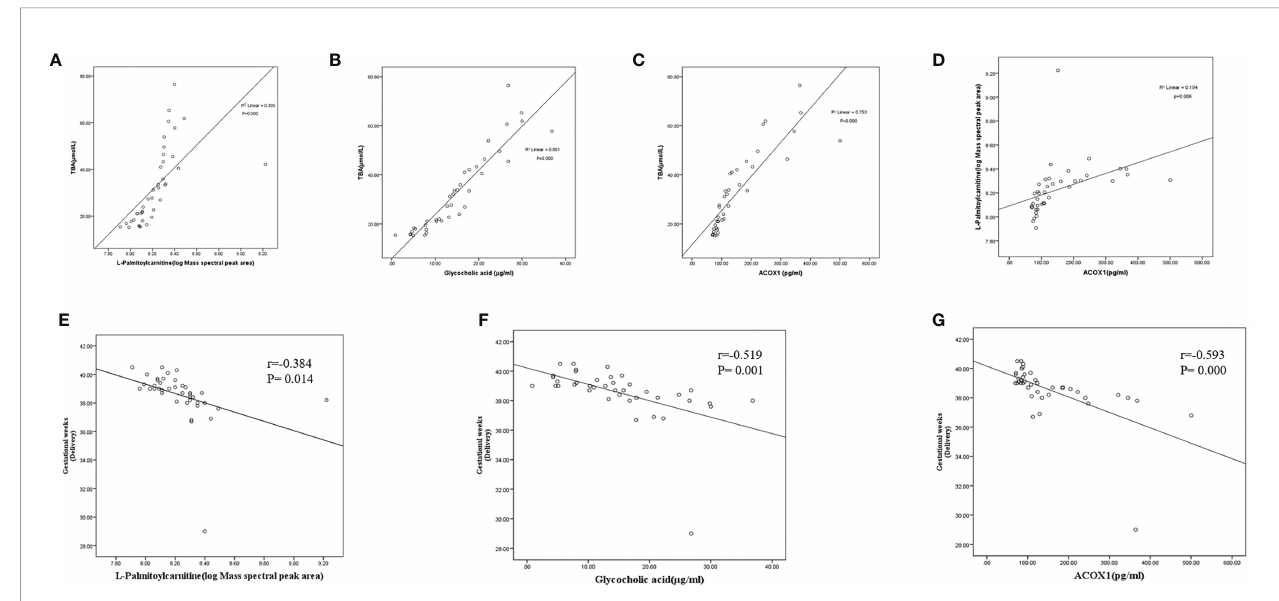
FIGURE 6 | Correlations between serum biomarker levels and gestational age (delivery) among pregnant women with ICP in the third trimester. (A) L- palmitoylcarnitine and TBA (r=0.395, P=0.000); (B) glycocholic acid and TBA (r=0.861, P=0.000); (C) ACOX1 and TBA (r=0.753, P=0.000); (D) ACOX1 and L- palmitoylcarnitine (R 2 =0.154, P=0.006); (E) L-palmitoylcarnitine and gestational weeks (delivery) (r=-0.384, P=0.014); (F) glycocholic acid and gestational weeks (delivery) (r=-0.519, P=0.001); (G) ACOX1 and gestational weeks (delivery) (r=-0.593,